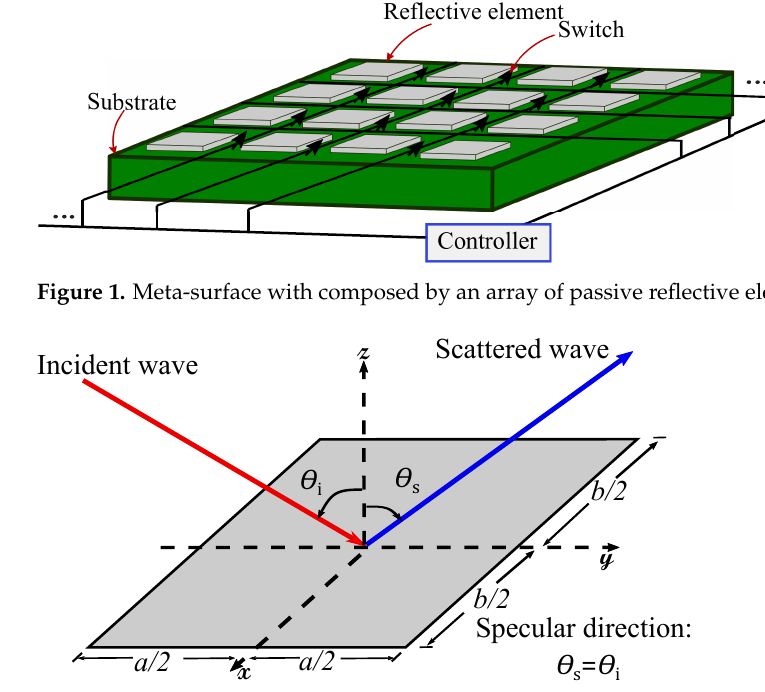
Figure 2. Snell’s law, the scattered wave by the a × b metal plate is strongest for the specular direction, i.e., θ i = θ s